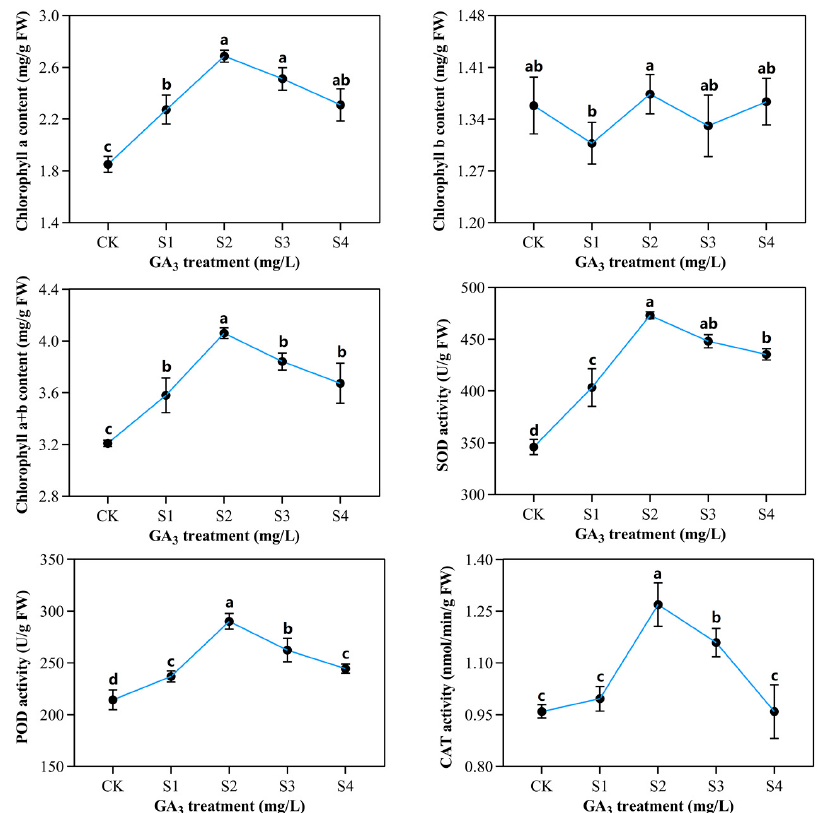
Figure 3. The influence of varying exogenous GA 3 concentrations on chlorophyll content and antioxidant enzymatic activities of sorghum seedlings developed in the presence of 150 mM NaCl. CK—0 mg/L GA 3 ; S1—25 mg/L GA 3 ; S2—50 mg/L GA 3 ; S3—75 mg/L GA 3 ; S4—100 mg/L GA 3 . Six sorghum plants from GA 3 treated (n = 3) and control leaves (n = 3) were used for the determination of chlorophyll contents, as well as superoxide dismutase (SOD), peroxidase (POD), and catalase (CAT) activities. All data are presented as the mean ± SD, Superscript different lowercase letters means significant difference ( p <0.05), Superscript same lowercase letters showed no significant difference ( p